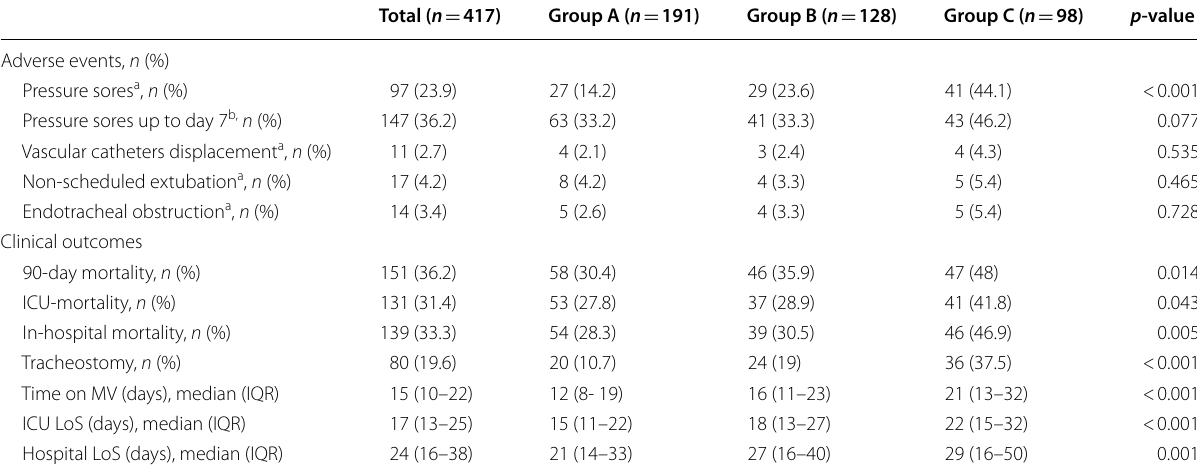
a Incidence relate to the first prone session b Cumulative incidence up to day 7 (considering